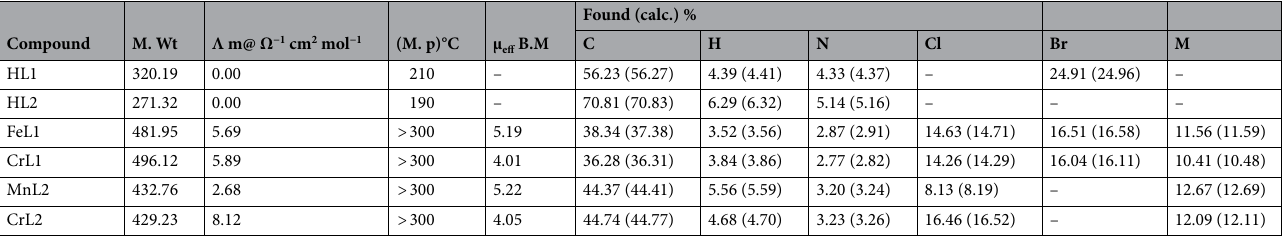
Table 1. Data on the two ligands’ new Cr(III), Fe(III), and Mn(II) complexes from elemental